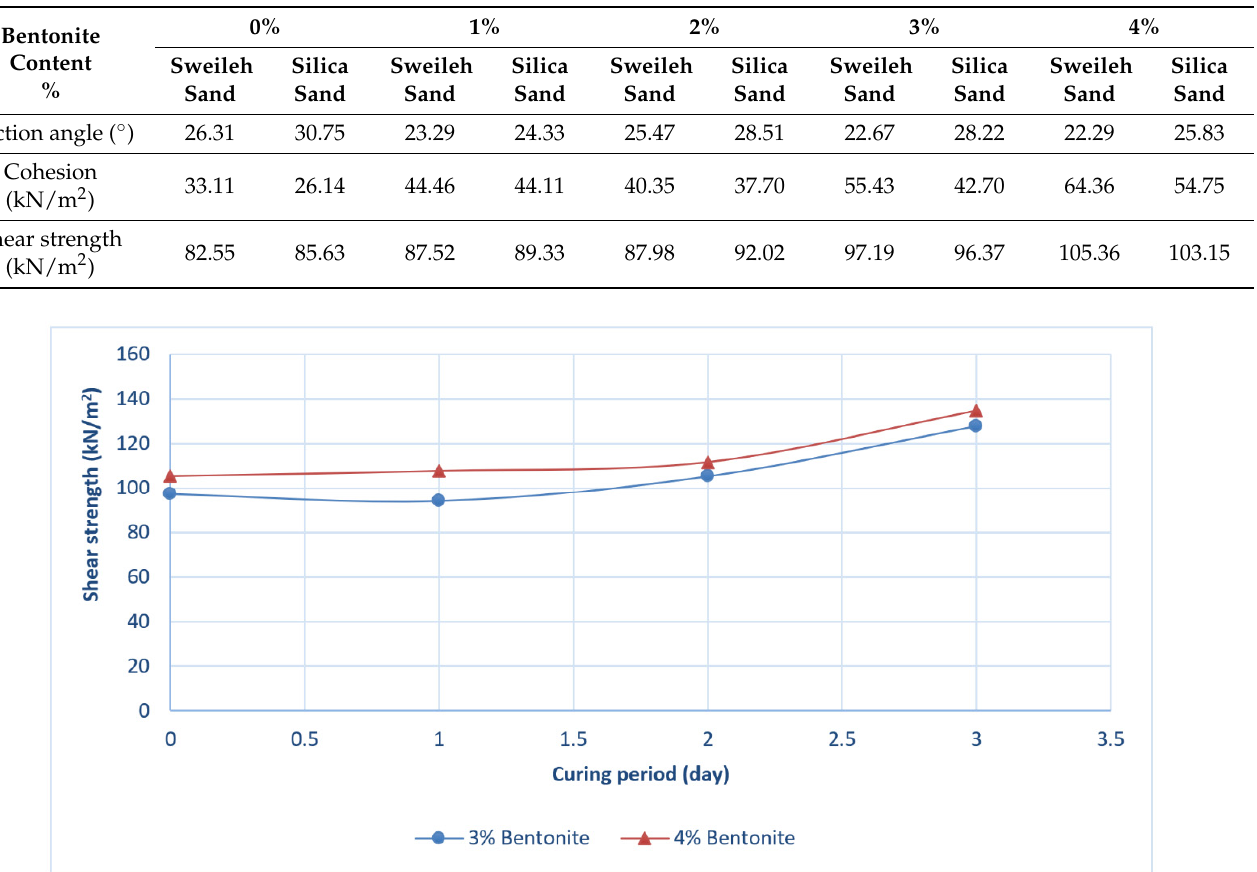
Figure 11. Shear strength values versus curing period for Sweileh sand stabilized with 3% and 4% bentonite clay.